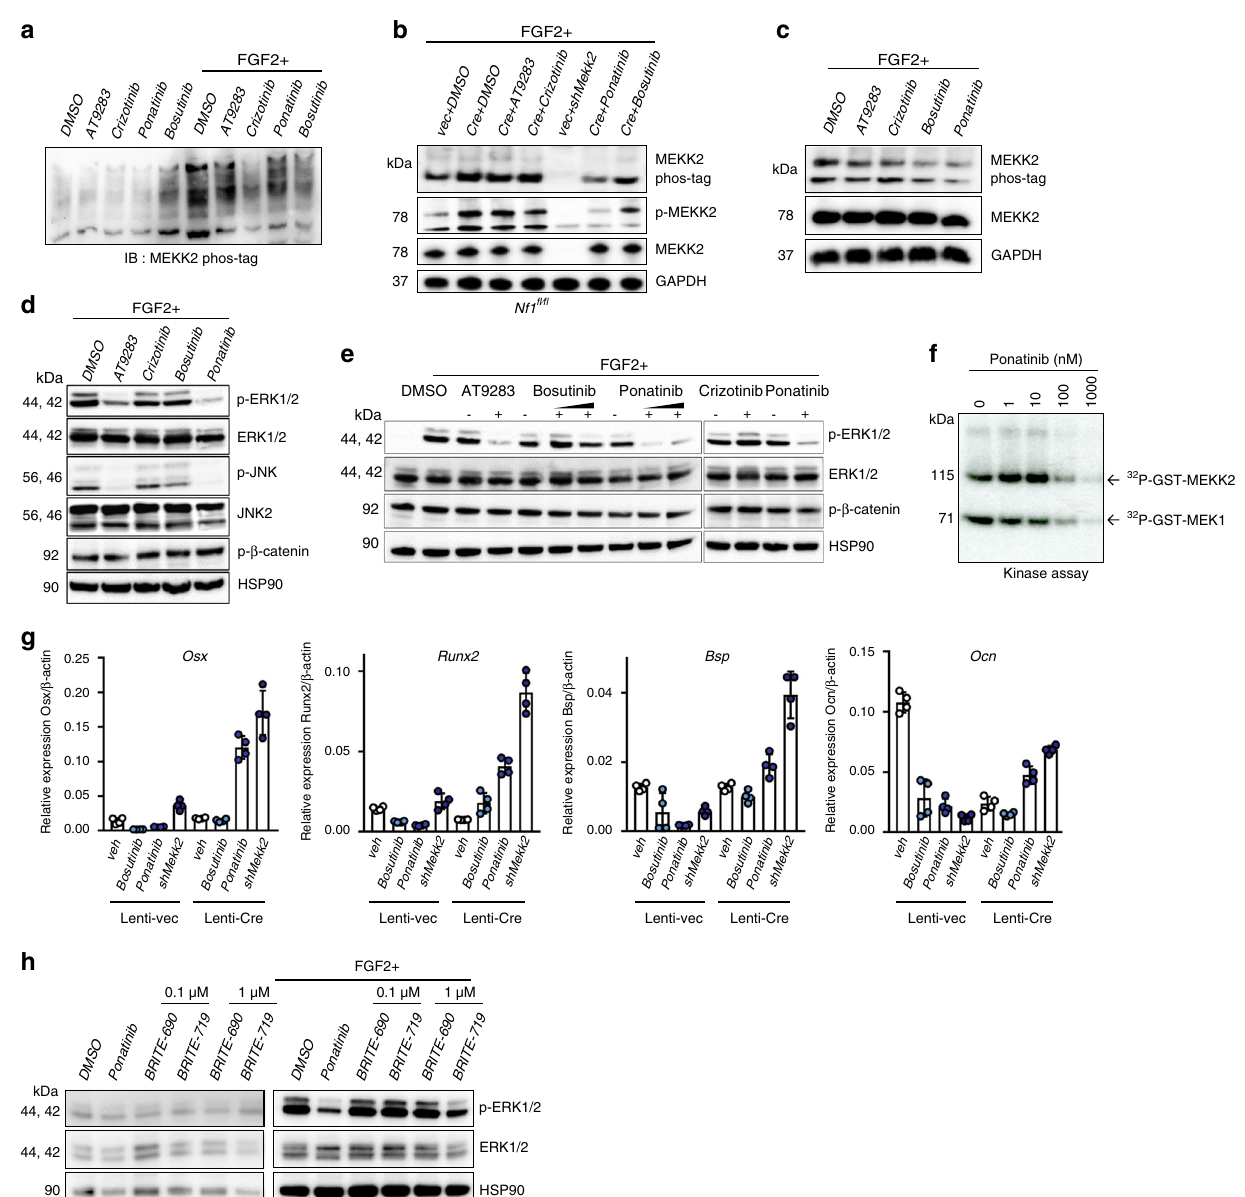
Fig. 3 Pharmacologic inhibition of MEKK2 prohibits ERK activation. a Primary COBs were immortalized through infection with a retrovirus expressing SV40 large T-Antigen. COBs were pre-treated with the indicated inhibitors (1 µ M, 30 min), then stimulated with or without FGF2 (25 ng/ml, 20 min) 30 min later. MEKK2 phosphorylation was analyzed by phos-tag electrophoresis. b MEKK2 phosphorylation was analyzed by either phos-tag electrophoresis or immunoblotting with anti-p-MEKK2 in primary Nf1 fl / fl osteoblasts infected with either vec or Cre lentivirus with the indicated inhibitors and FGF2 stimulation. c hMSCs were treated with the indicated inhibitors, then MEKK2 phosphorylation was examined by phos-tag electrophoresis. d WT immortalized COBs were lysed and immunoblotted for the indicated antibodies after inhibitor treatment. e Activation of ERK was detected in Saos-2 cells after incubation with the indicated inhibitors and stimulation with or without FGF2. f Puri fi ed unactivated GST-MEK1 was incubated with puri fi ed GST- MEKK2 and the indicated doses of ponatinib, and kinase activity of MEKK2 was analyzed by an in vitro kinase assay. g Expression levels of osteoblast genes in primary Nf1 fl / fl osteoblasts infected with either vec or Cre lentivirus. After infection, these cells are treated with the indicated inhibitors or a Mekk2 - targeting shRNA and cultured for 14 days ( n = 4 biologically independent samples). mean ± s.d. h Saos-2 cells were treated with DMSO, ponatinib (1 µ M), BRITE-0600690 (BRITE-690, inactive compound), and BRITE-0600719 (BRITE-719, active compound) for 1 h with or without FGF2 stimulation. Phosphorylation levels of ERK1/2 were assessed by immunoblotting. All data shown are representative of either two or three total independent experiments. All unprocessed blots are provided in Supplementary Fig. 5. Source data are provided as a Source Data fi